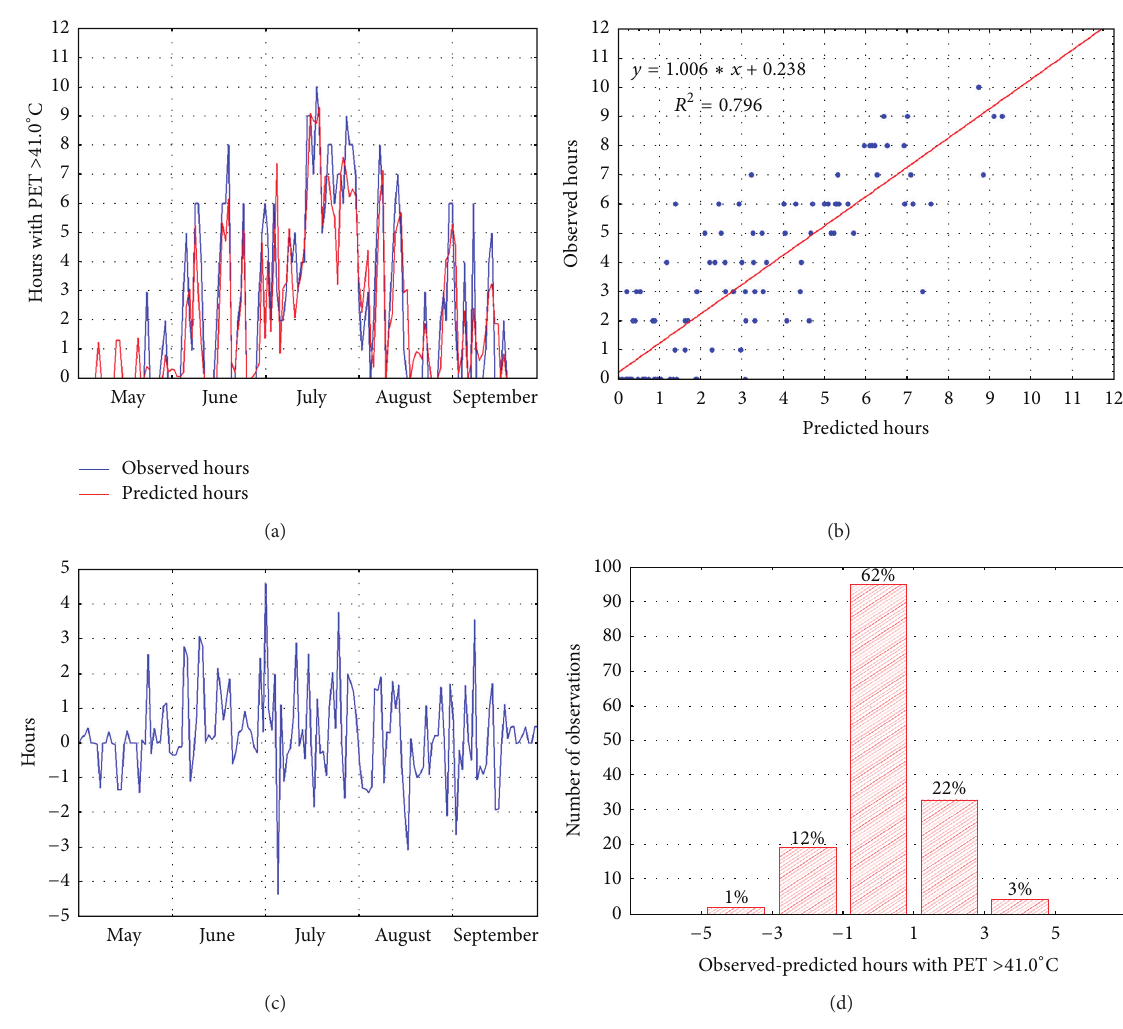
Figure 8: Observed versus predicted hours with PET > 41.0 ∘ C (a); scatter plot between the observed and predicted hours with PET > 41.0 ∘ C (b); observed minus predicted hours with PET > 41.0 ∘ C (c) and histogram with the absolute differences between the observed and the predicted hours with PET > 41.0 ∘ C (d). One day ahead prognosis. Warm period of 2011.